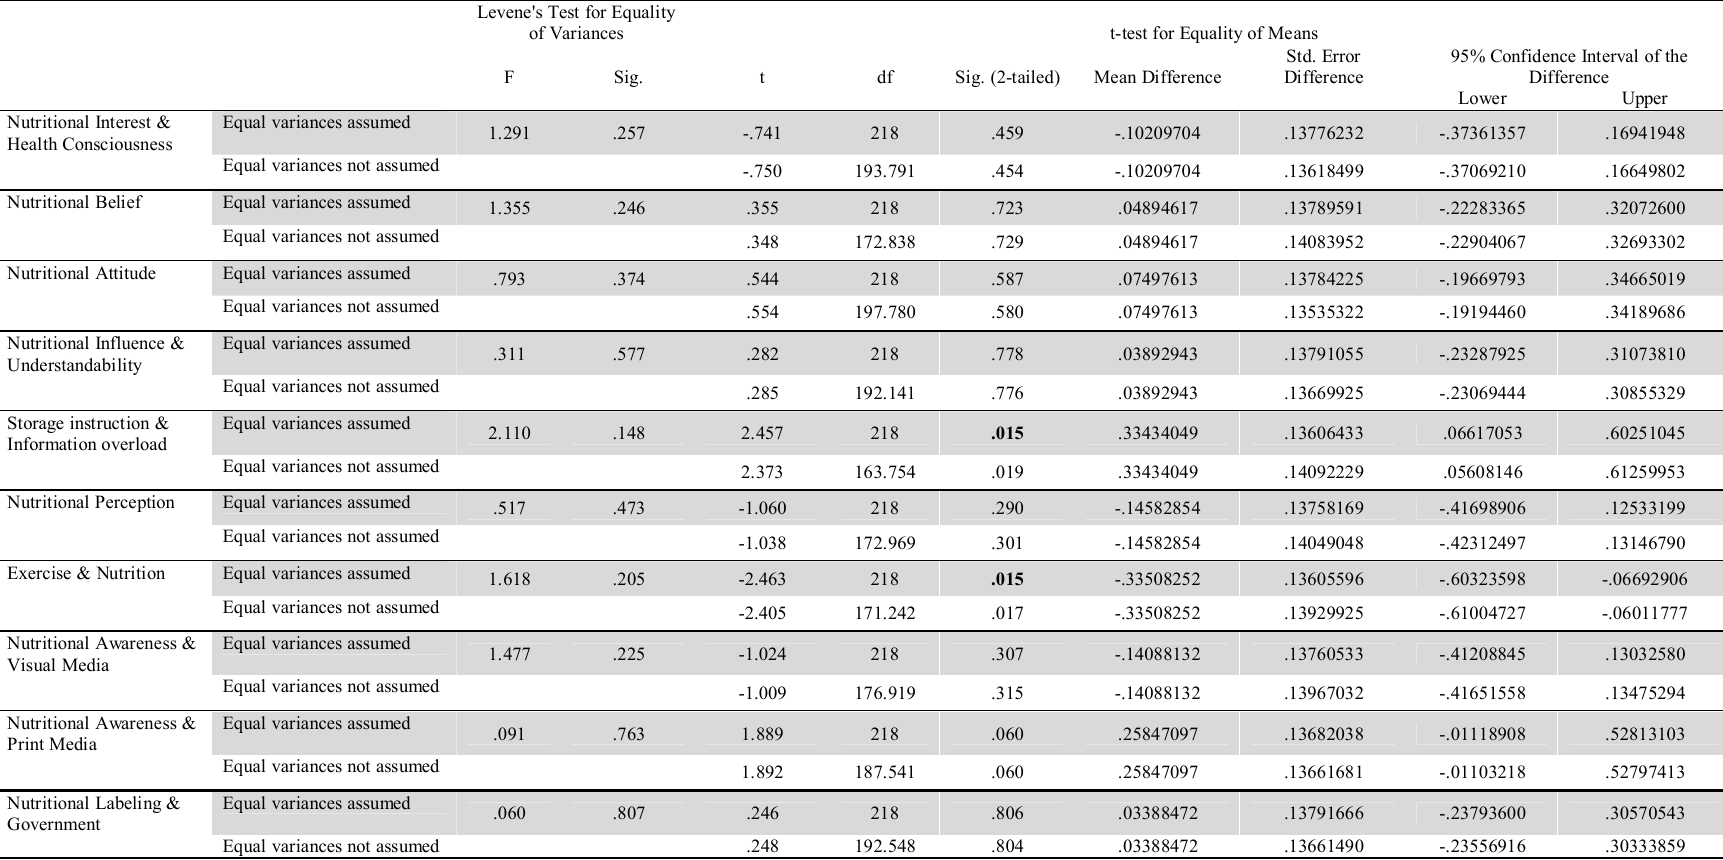
Independent samples test